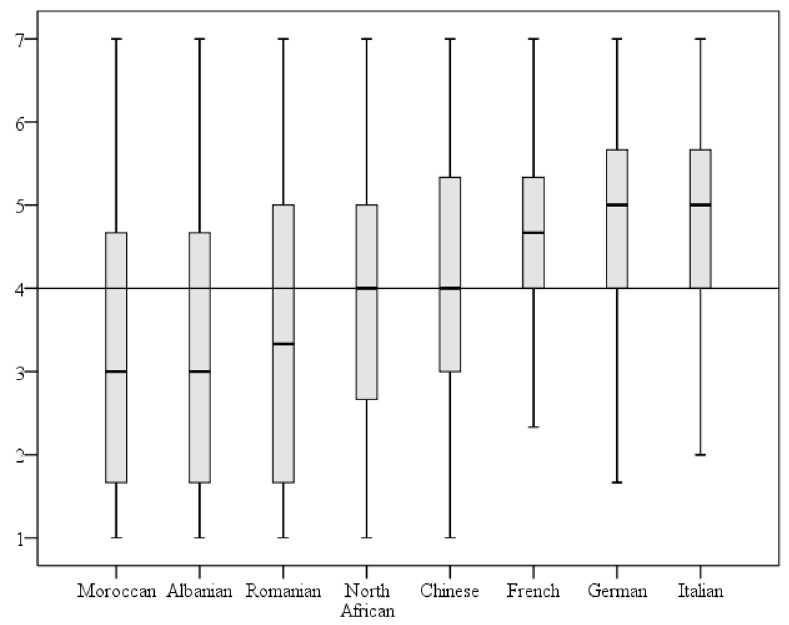
Figure 1. Box plots of group ratings for all 8 target groups. Note . The line within each box indicates the median, the top of each box indicates the 75th percentile, and the bottom of each box indicates the 25th